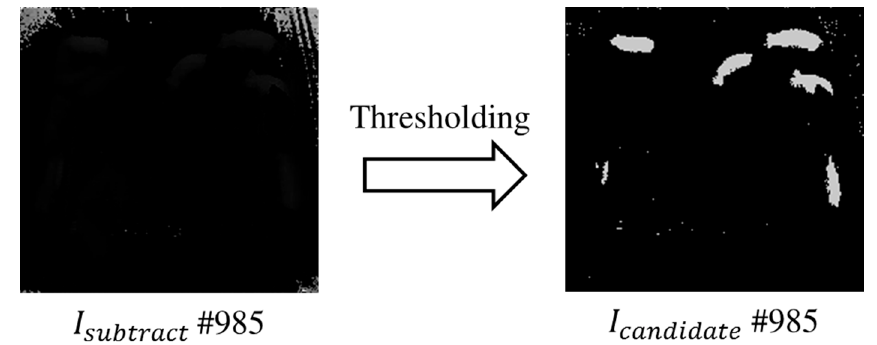
Figure 8. Result of background subtraction.